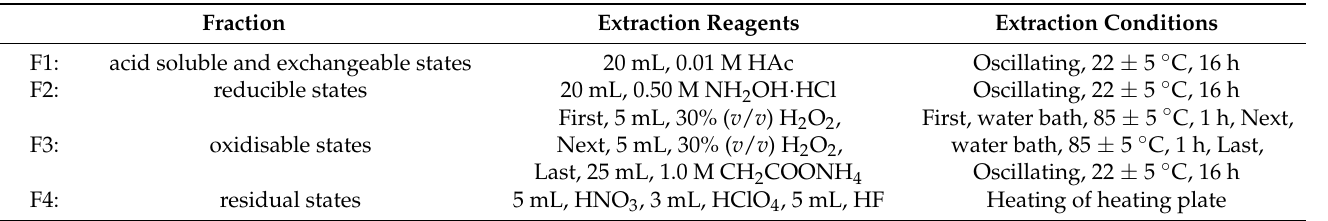
Table 3. Modified BCR three-step sequential extraction